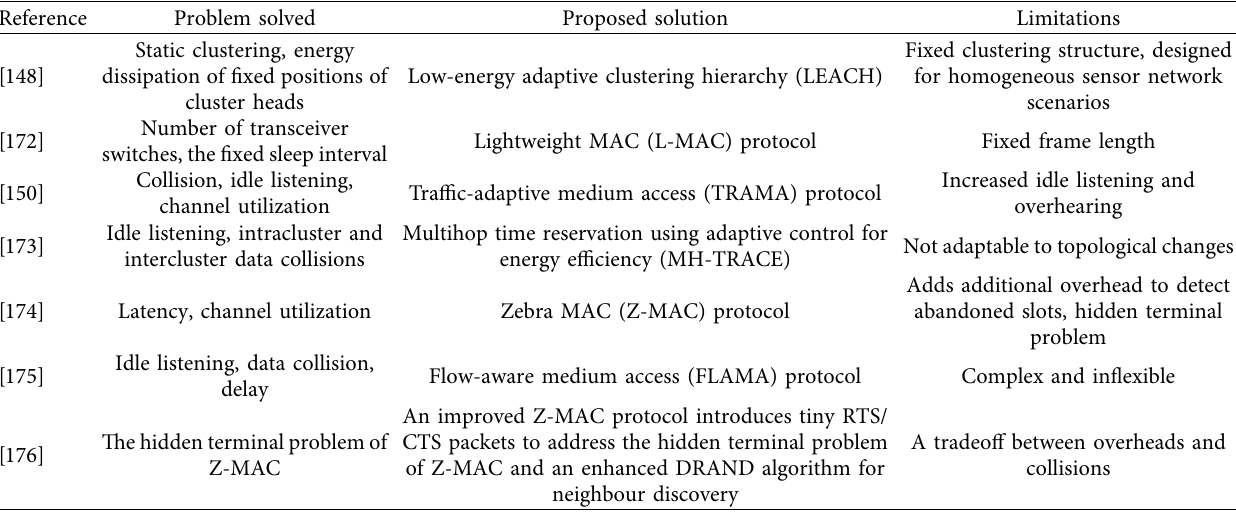
Table 4: Comparison of studies on semisynchronous low duty cycle MAC protocols.